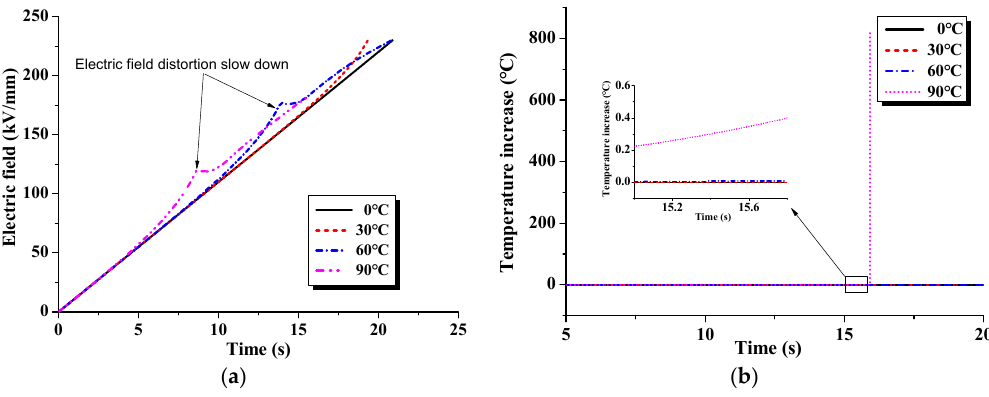
Figure 10. Variations in the highest electric field and temperature before breakdown. ( a ) Variation in the highest electric field, ( b ) Variation in the highest temperature.